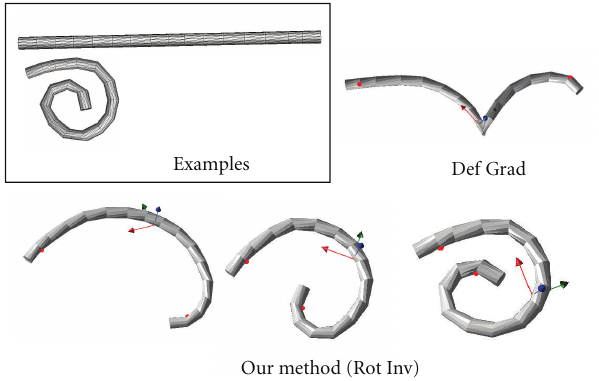
Figure 15: If we use deformation gradient (Def Grad) that was used in MeshIK [2], our method results in the discontinuity artifact because Def Grad is defined in the absolute world coordinate (top right). Our method based on a rotation-invariant mesh representation (Rot Inv) naturally deforms the model using the examples that involve large rotations and bending (bottom).